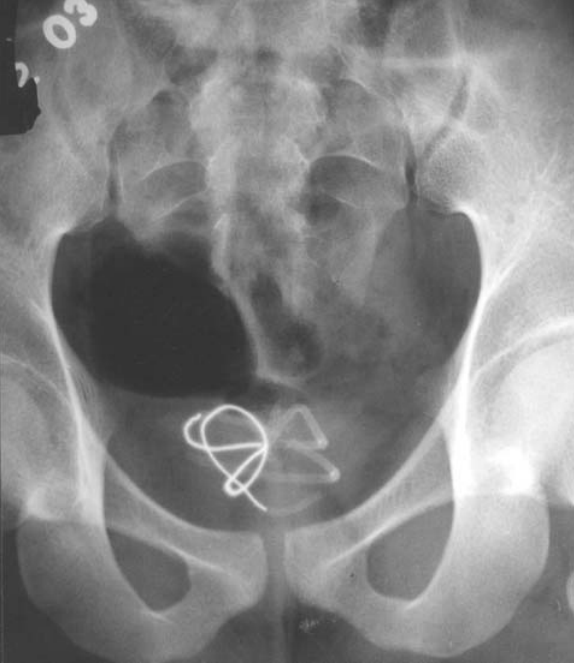
Figure 1 – X-ray of the pelvis showing coiled up wire in urinary